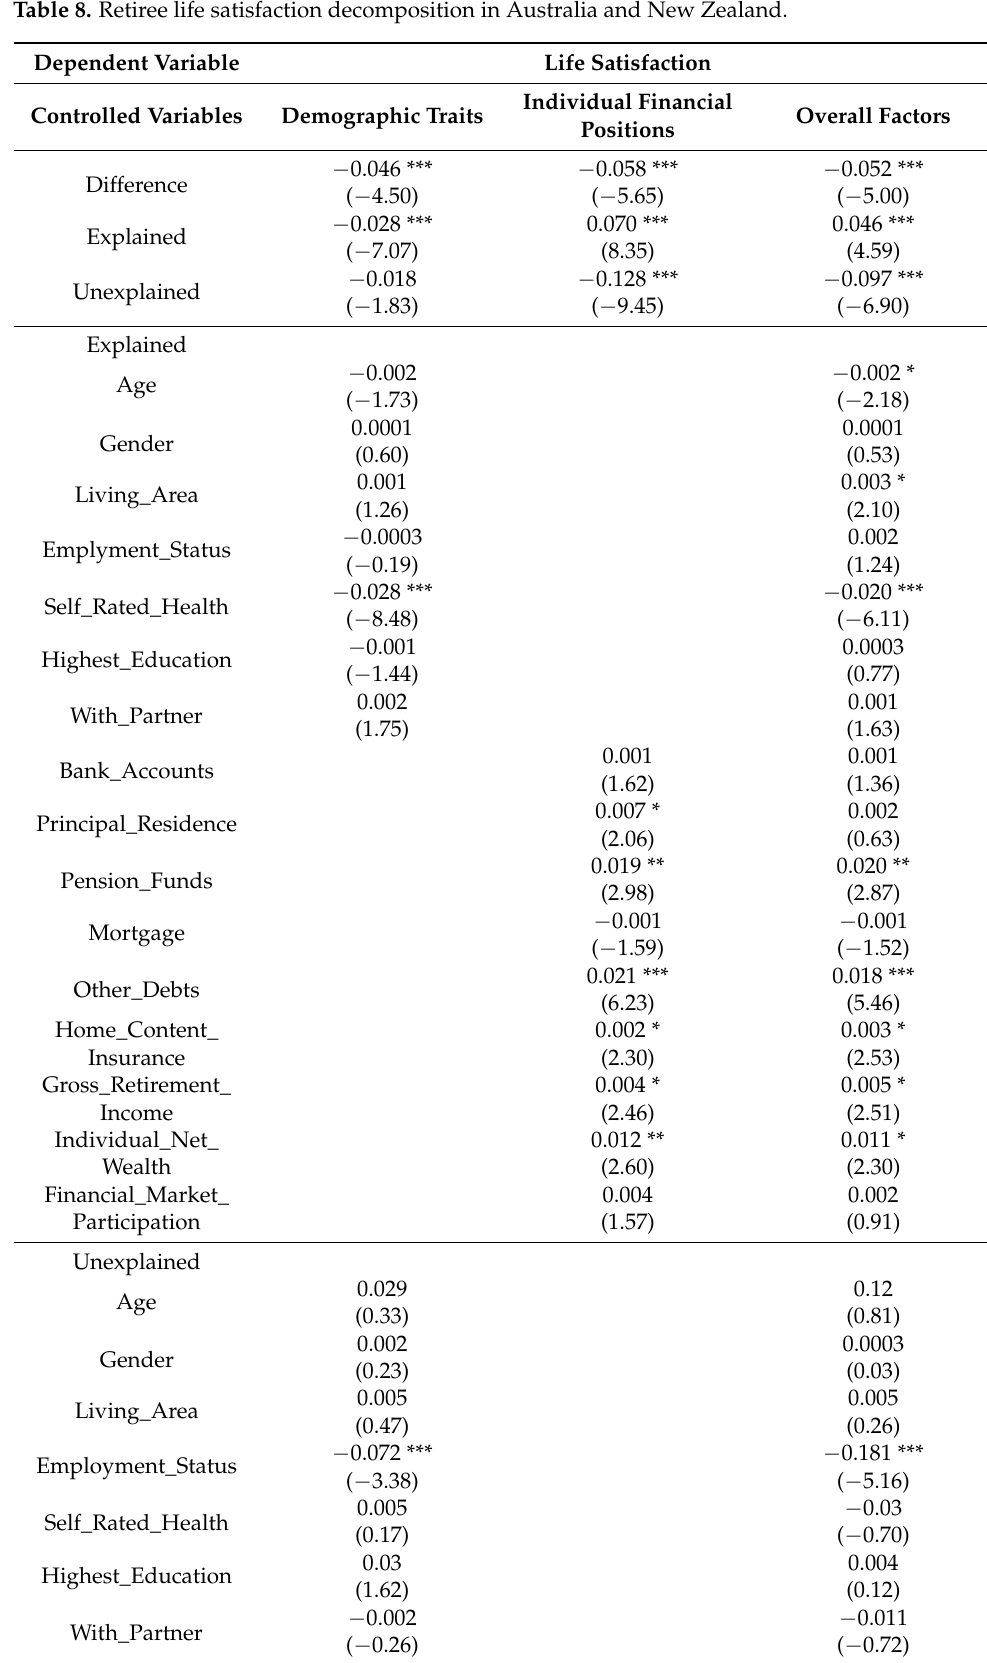
Table 8. Retiree life satisfaction decomposition in Australia and New